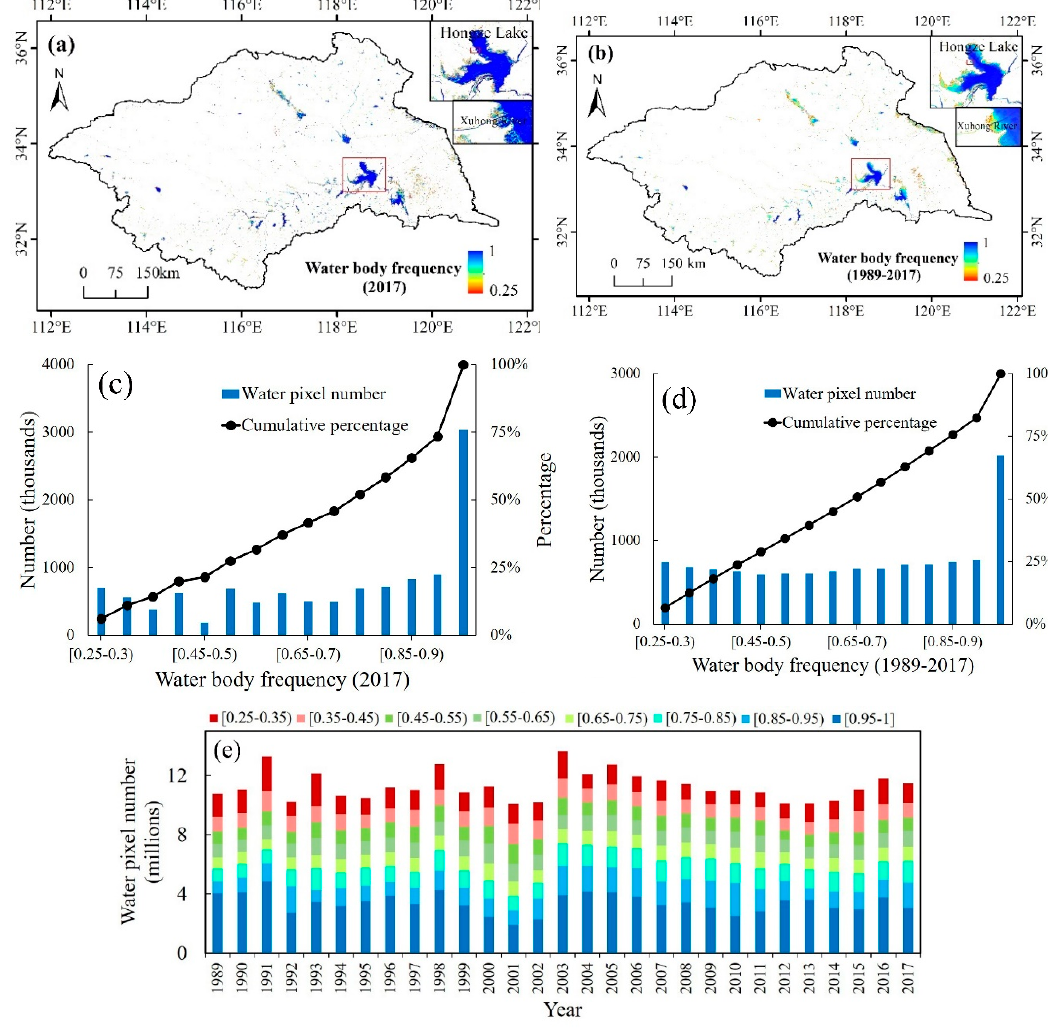
Figure 5. The water frequency distribution in Huai River Basin: Water frequency distribution map of 2017 ( a ) and 1989–2017 ( b ); The number of pixel distributions of water at di ff erent frequency levels with a bin of 0.05 in 2017 ( c ) and 1984–2015 ( d ); The number of pixel distributions of water at di ff erent frequency levels with a bin of 0.1 during 1989–2017 ( e ).